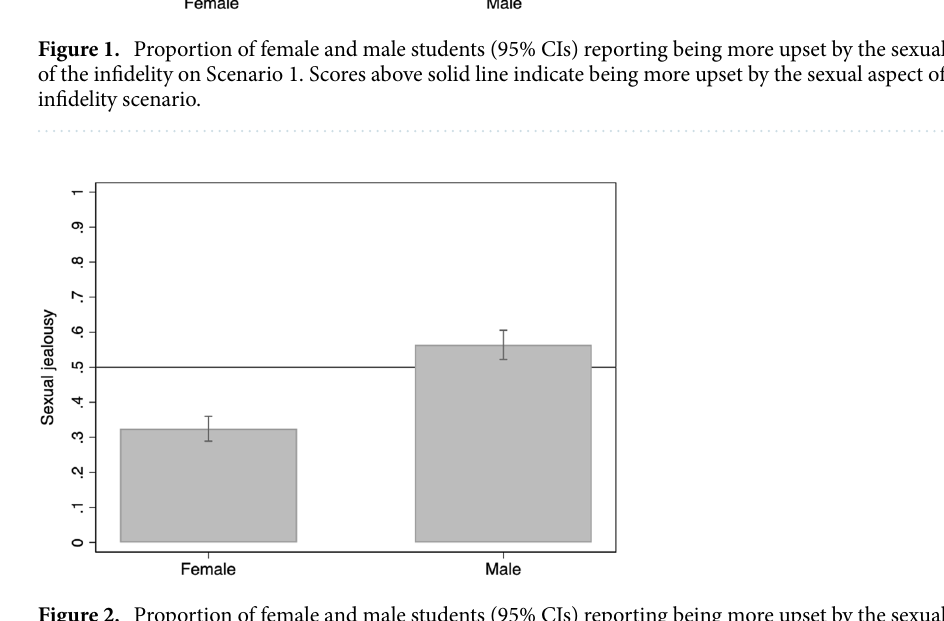
Figure 2. Proportion of female and male students (95% CIs) reporting being more upset by the sexual aspect of the infidelity on Scenario 2. Scores above solid line indicate being more upset by the sexual aspect of the infidelity scenario.